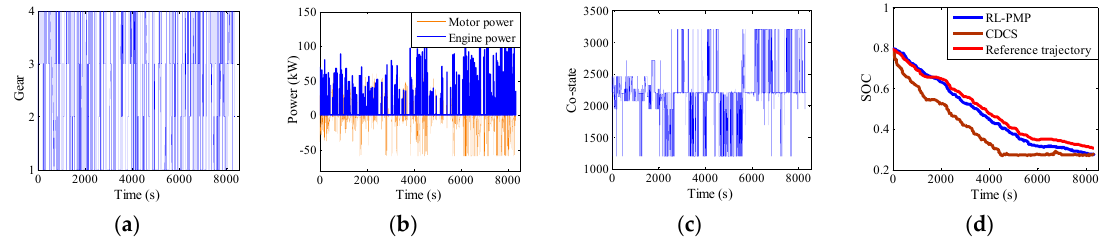
Figure 22. The HIL results of No.22. ( a ) denotes the gears, ( b ) denotes the powers of the motor and the engine, ( c ) denotes the co-state, and ( d ) denotes the SOC trajectories.